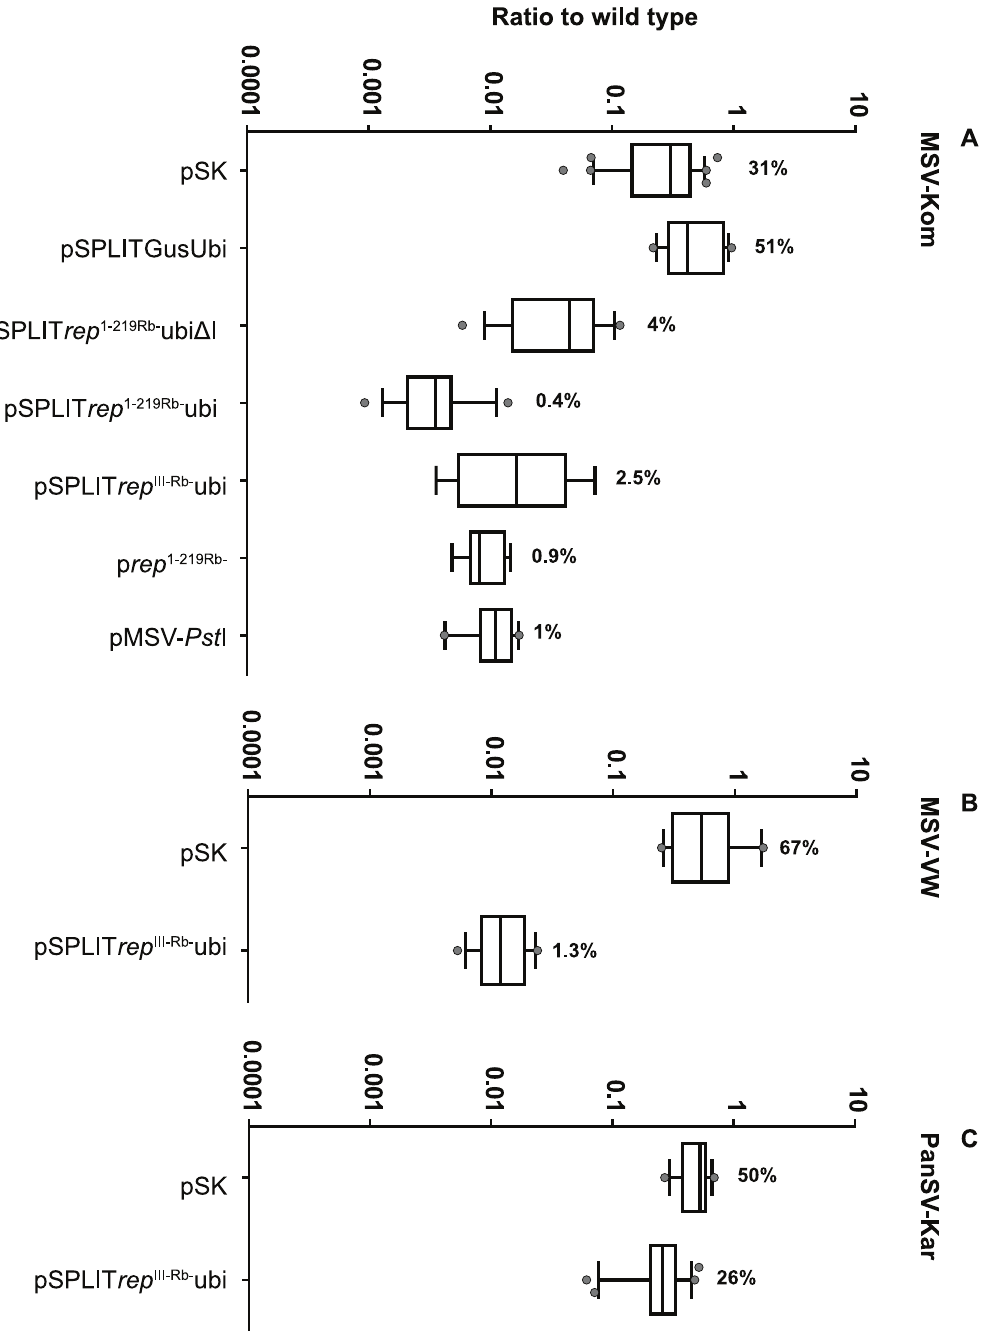
Figure 7. Vertical box-and-whisker plots summarising real-time PCR data on all constructs bombarded at a 5:1 weight ratio with infectious clones of diverse MSV strains and another mastrevirus species. A) MSV-Kom. The plots were constructed as in Figure 6. The number of replicates (i.e. the number of bombarded samples) were as follows: pSK, 34; pSPLITGusUbi, 18; pSPLIT rep 1-219Rb- Ubi D I, 18; pSPLIT rep 1-219Rb- Ubi, 14; pSPLIT rep III-Rb- Ubi, 8; p rep 1-219Rb- , 9; pMSV- Pst I, 11. Plots in B-C) were constructed as described for A), but this time either pSPLIT rep III-Rb- Ubi or pSK were co-bombarded with infectious clones of: B) the MSV-B strain isolate VW; and C) the PanSV strain A isolate Kar. The number of replicates for B) were: pSK, 11; pSPLIT rep III-Rb- Ubi, 14. The number of replicates for C) were: pSK, 16; pSPLIT rep III-Rb- Ubi, 25. All real-time PCRs were performed on total DNA extracted from BMS cells four days post-bombardment. doi:10.1371/journal.pone.0105932.g007 at a 5:1 or 1:1 ratio. For pSPLIT rep III-Rb- Ubi, the already low ratio; P= 0.0603). This is understandable for p rep 1-219Rb- consid- ering that at a 1:1 ratio, detected amplicons were probably from levels of viral DNA detected at a 1:1 ratio were reduced so as to input plasmid and not replicated viral DNA, hence there would be make them indistinguishable from input DNA levels. no difference in input pKom602 DNA levels whether bombarded